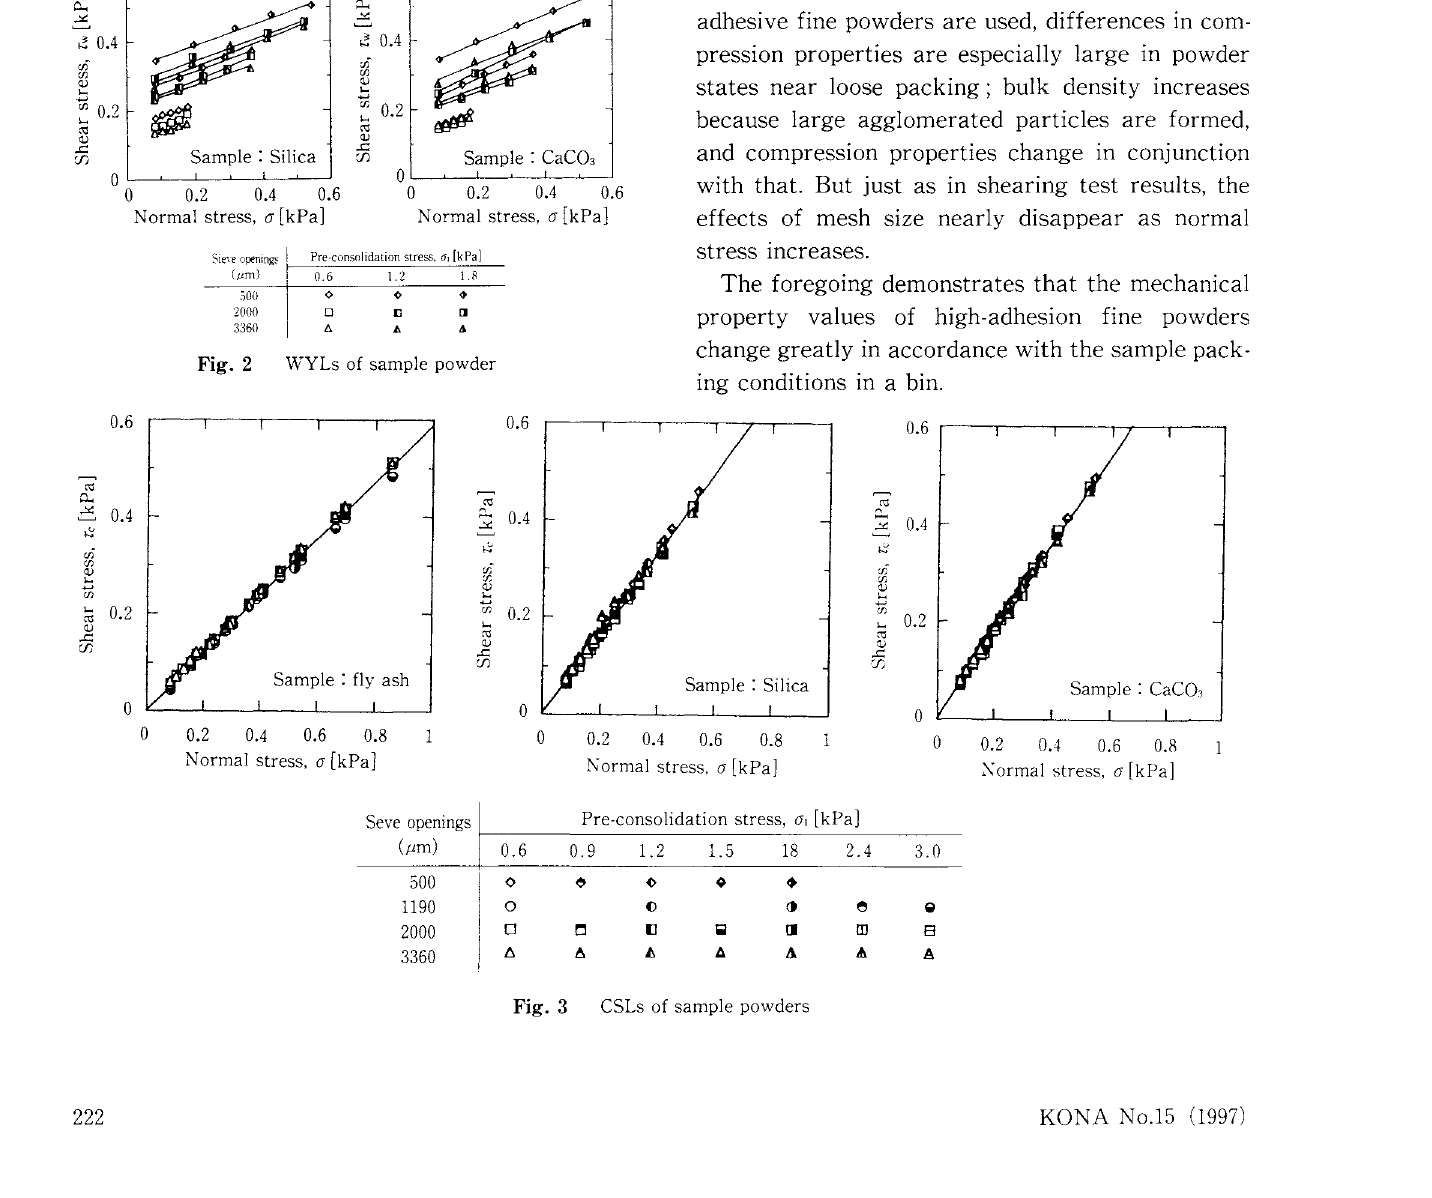
Fig. 2 WYLs of sample powder